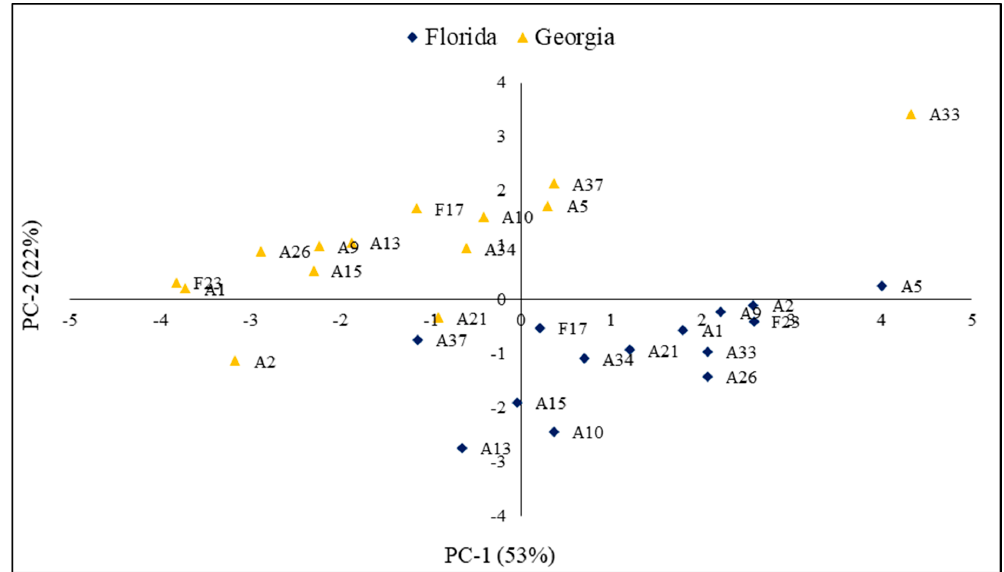
Figure 1. Scores plot of first two principal components.